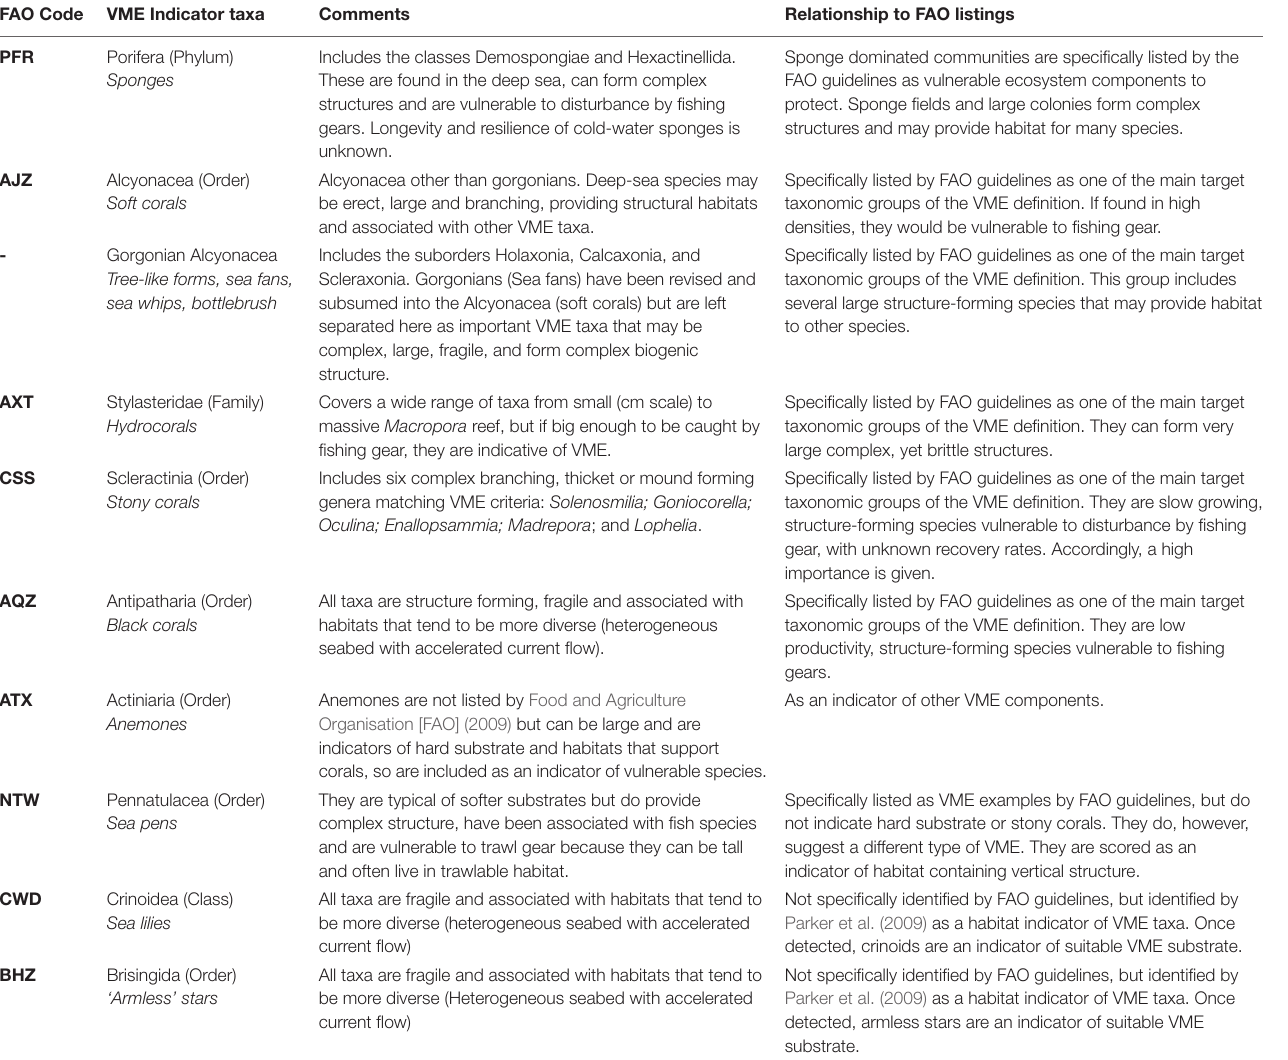
TABLE 1 | Rationale for the designation of VME Indicator taxa (modified from Parker et al.,